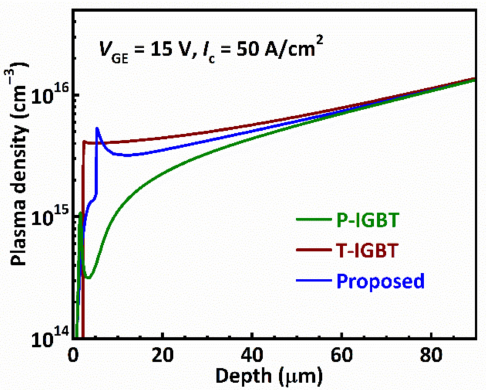
Figure 3. Plasma density in vertical direction of the studied P-IGBT, T-IGBT, and the proposed SiC IGBT at I C = 50 A/cm 2